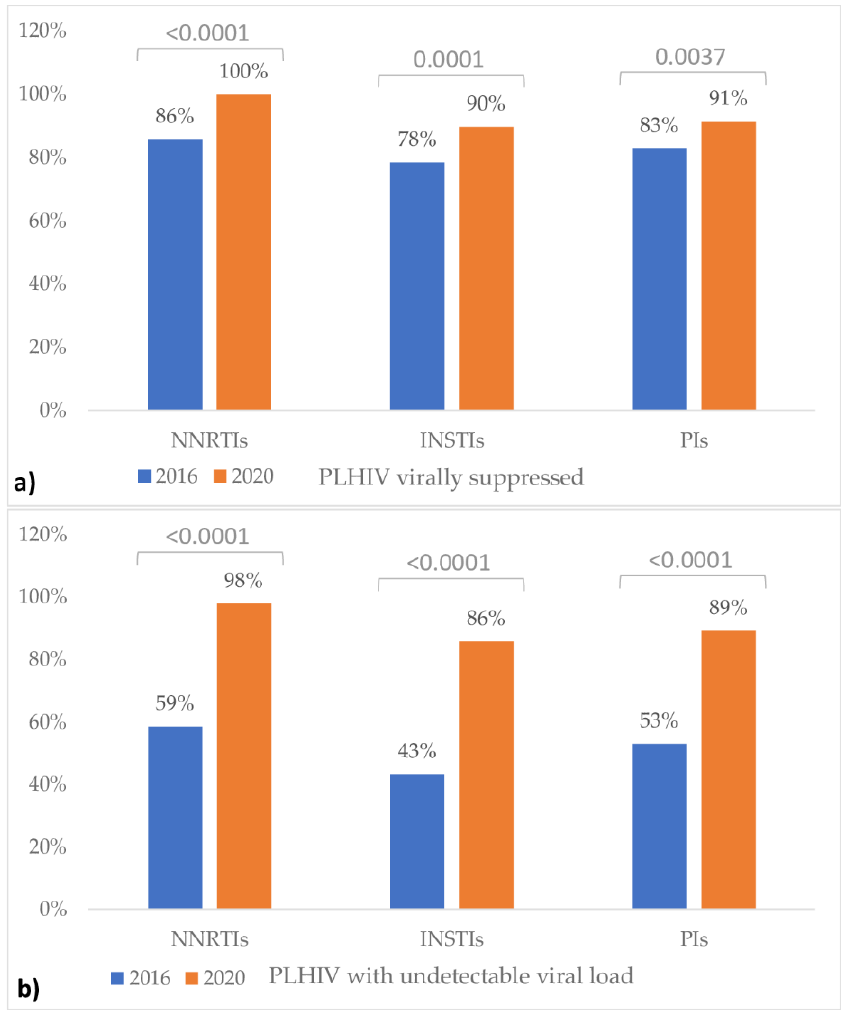
Figure 1. Percentage of PLHIV with viral suppression ( a ) and, respectively, PLHIV with undetectable viral load ( b ) by ART regime. PLHIV = patients living with HIV infection; ART = antiretroviral therapy; NNRTIs = non-nucleoside reverse transcriptase inhibitors; NSTIs = integrase strand transfer inhibitors; PIs = protease inhibitors. The p -values above the columns correspond to the Z-test for proportions.